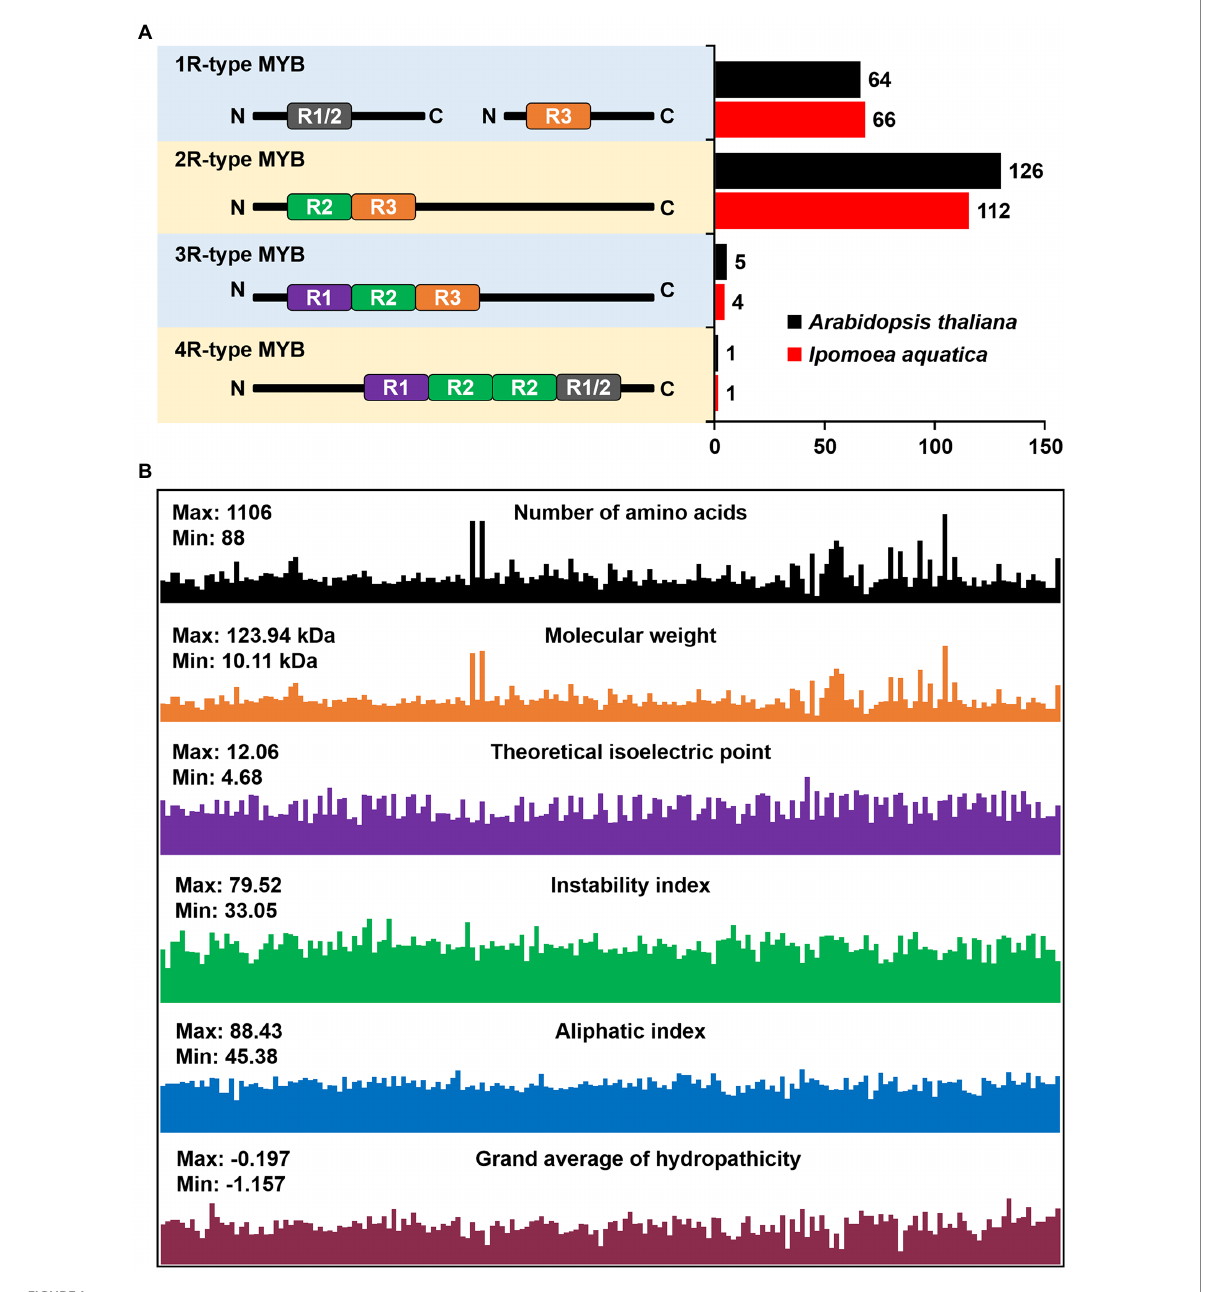
FIGURE 1 Identification of IaMYB genes. (A) The number of MYB gene in Ipomoea aquatica and Arabidopsis thaliana . The MYB genes were classified into four types accordding to the arrangement of MYB repeat in each gene, namely 1R-type MYB , 2R-type MYB , 3R-type MYB , and 4R-type MYB (Dubos et al., 2010). (B) The physicochemical properties of IaMYB